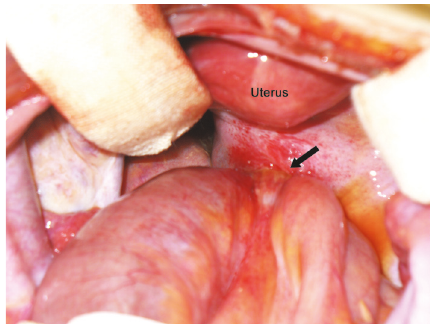
Figure 2: Operative findings. The distal ileum is herniated into the defect of the Pouch of Douglas (arrow).